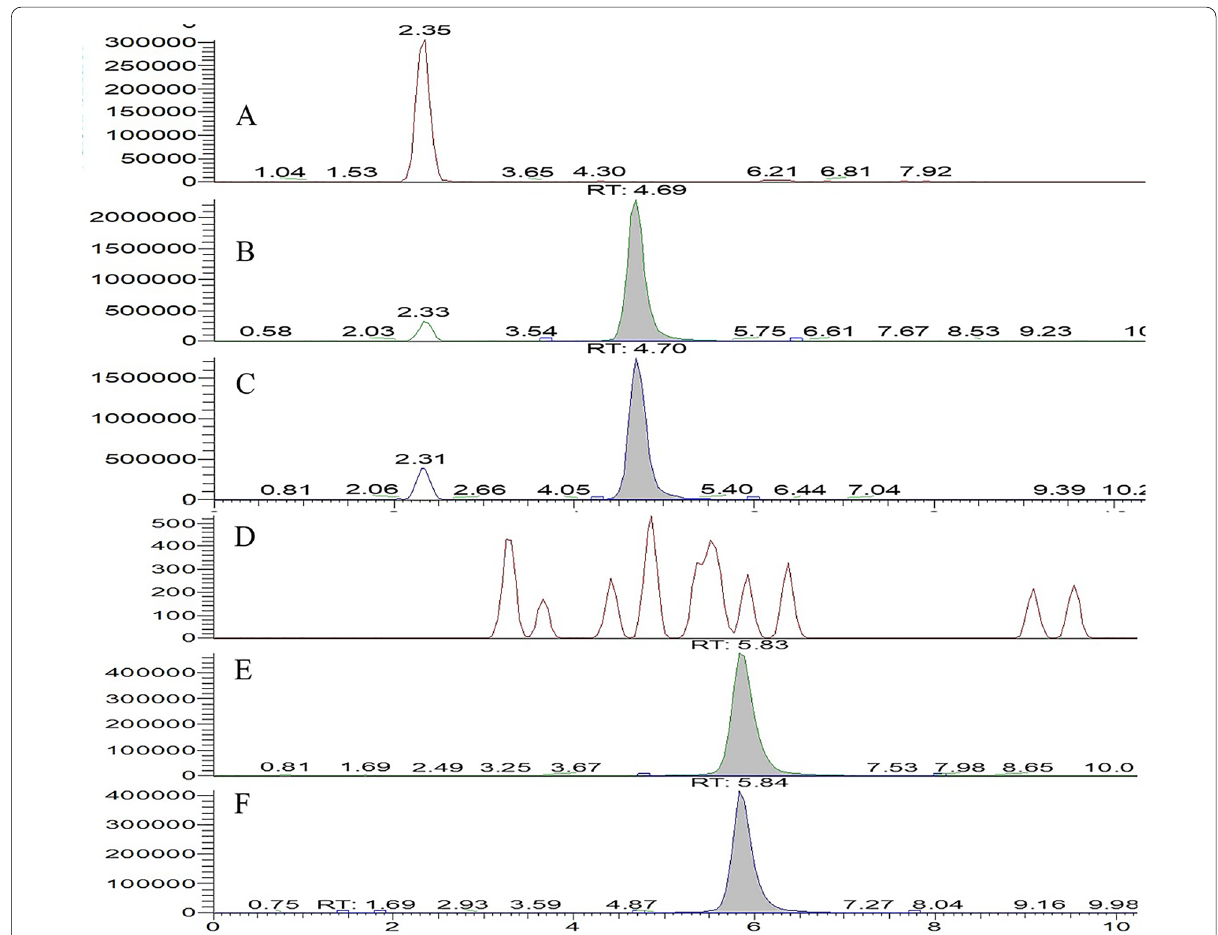
Fig. 1 Typical SIM chromatograms for the determination of COS 2 and COS 3 in serum: blank matrix ( A ) ( D ); blank matrix spiked with COS 2 ( B ) and COS 3 ( E ); after intragastric administration of 500 mg/kg COS 2 ( C ) and after intragastric administration of 500 mg/kg COS 3 ( F